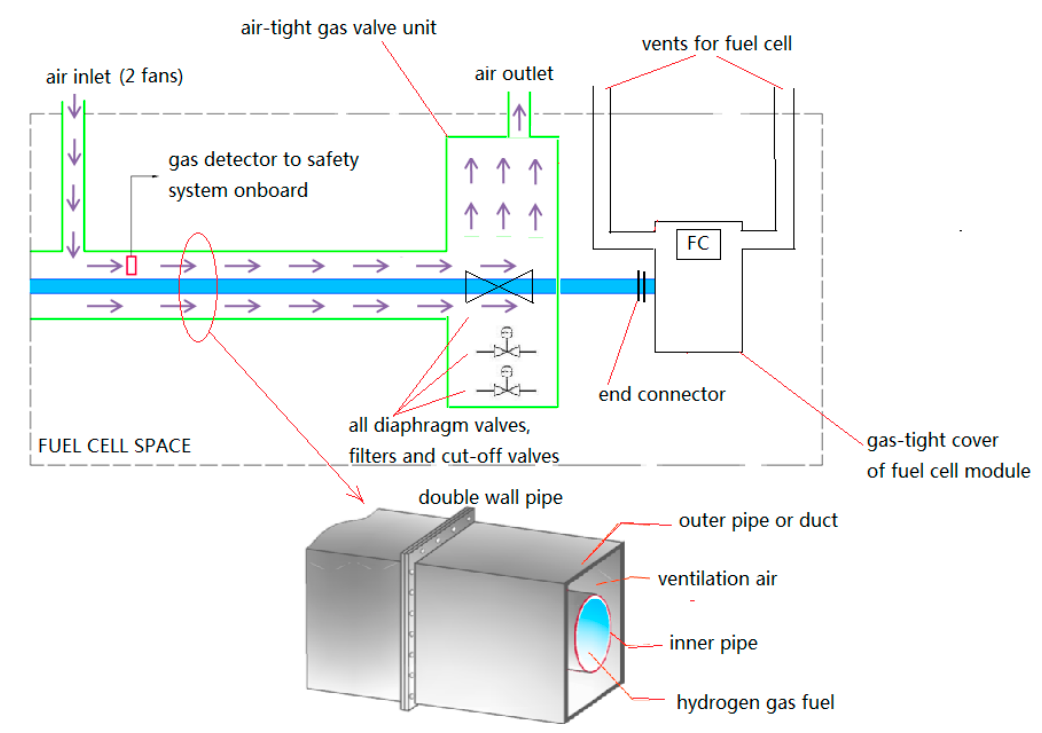
Figure 7. Schematic design of a double-wall piping system, air-tight gas valve unit, and gas-tight cover of the fuel cell.